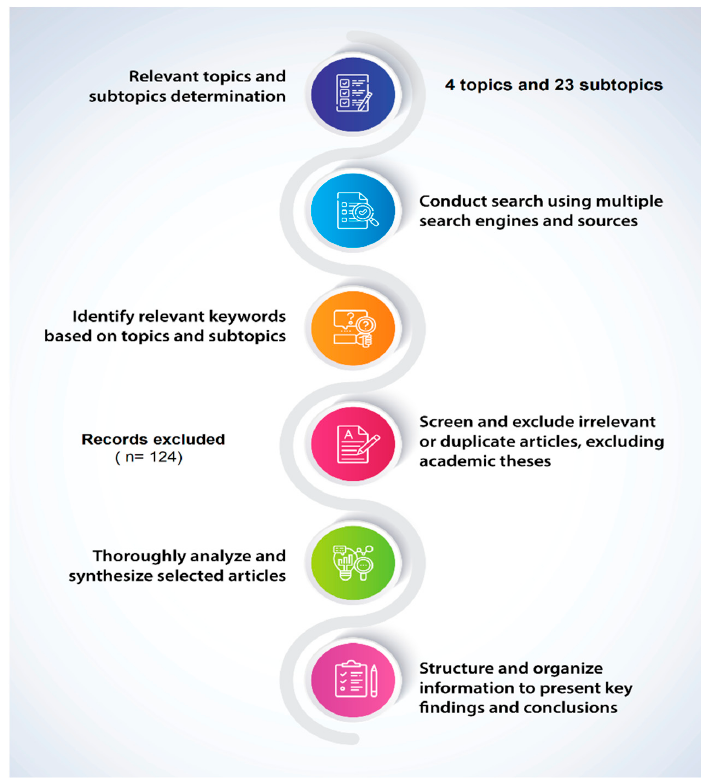
Figure 1. Review process work fl ow .